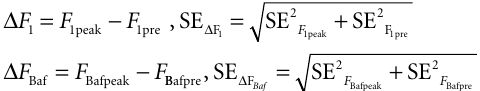
F : response to 20 APs at 100 Hz (average of at least 4 20